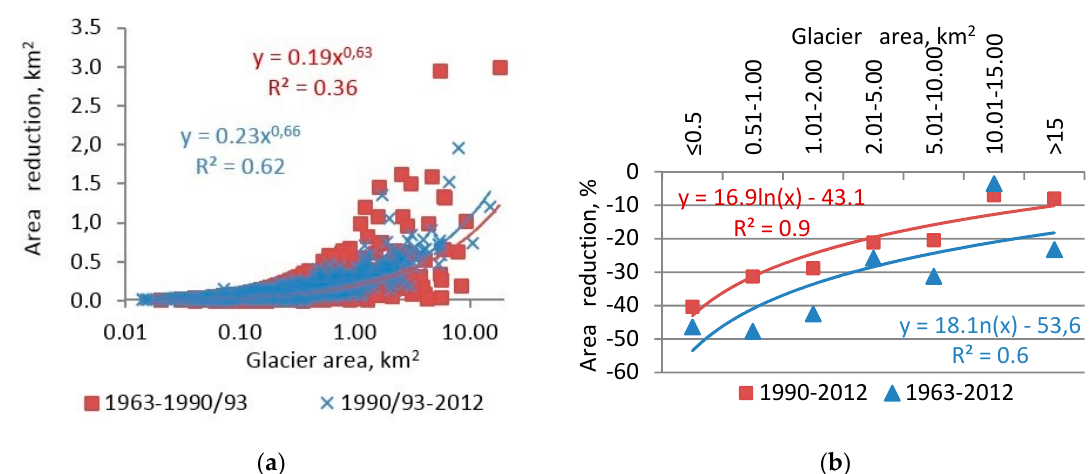
Figure 5. Scatter plot of ( a ) absolute glacier area loss and ( b ) relative area loss over the two assessment periods versus the initial glacier areas as in 1962/63 and 1990/93.